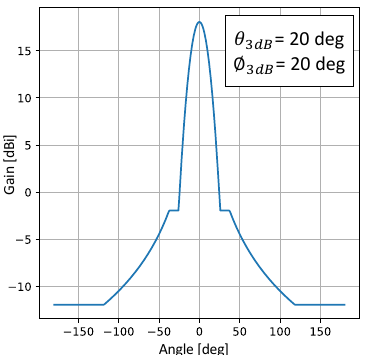
Figure 4. Example of an antenna pattern for vertical or horizontal